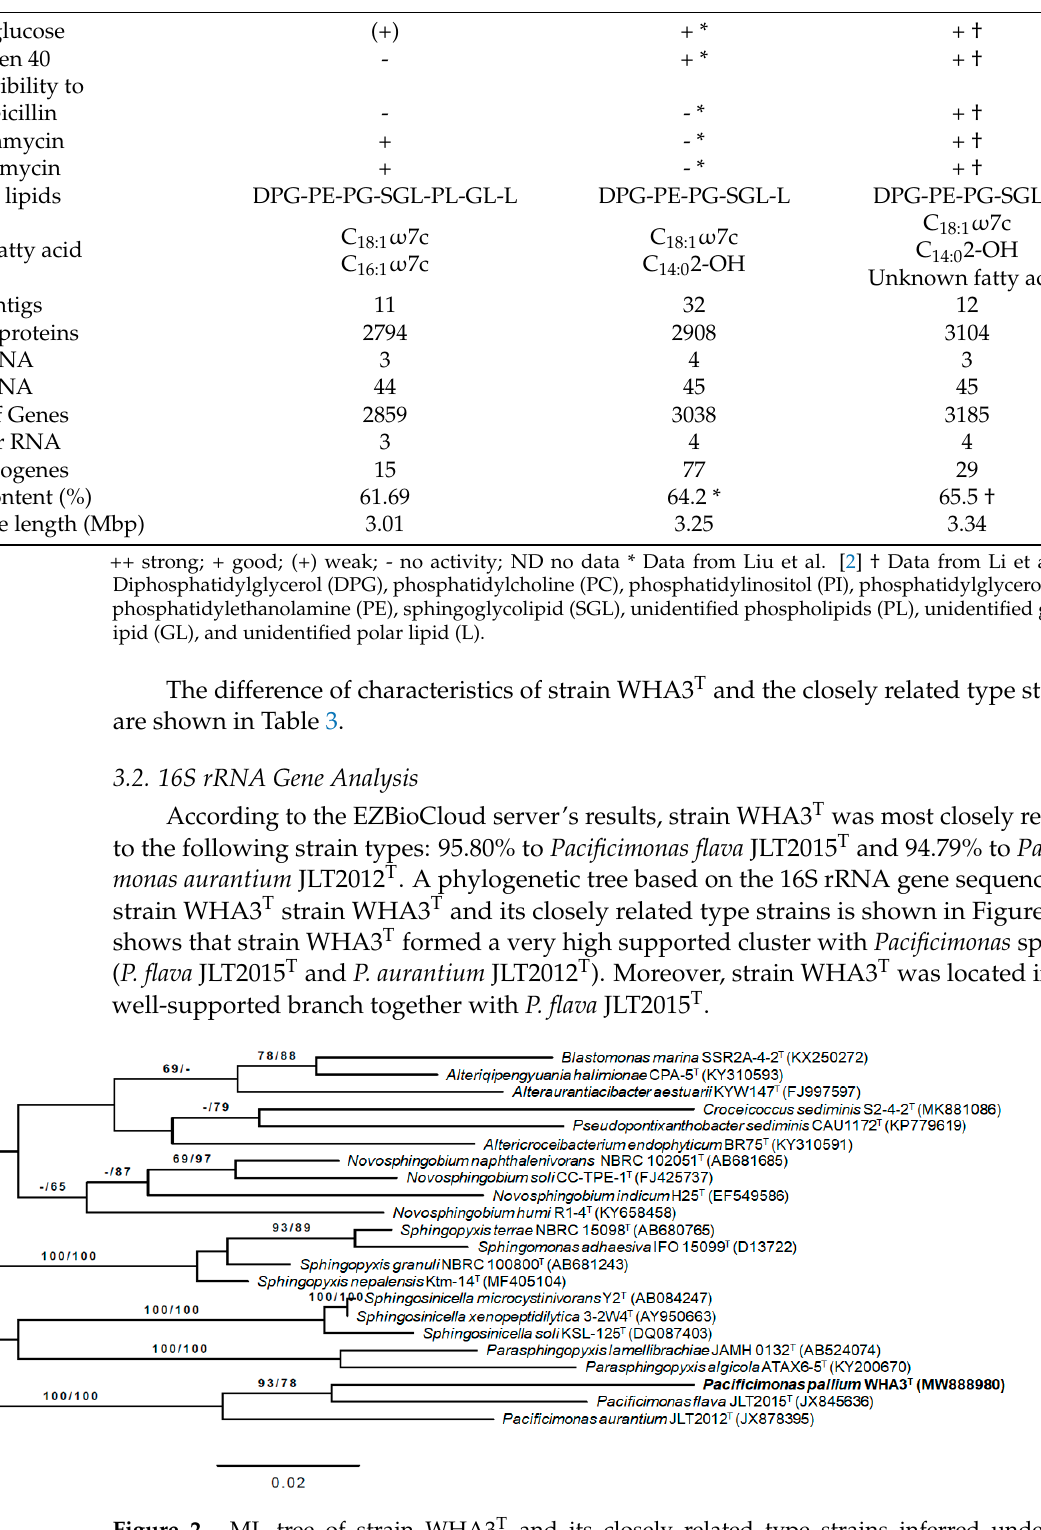
Figure 2. ML tree of strain WHA3 T and its closely related type strains inferred under the values (above 60%) from ML (left) and MP (right) bootstrapping. The ML and MP bootstrapping average supports were 69.63% and 79.05%,